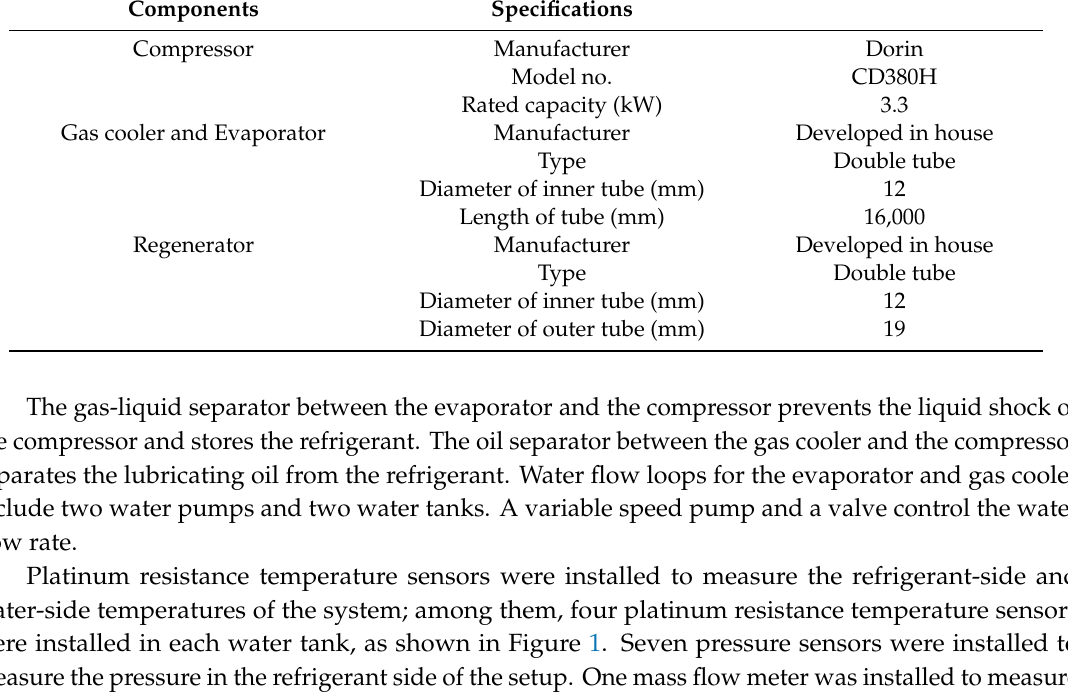
Figure 1. Schematic of the experimental setup. Table 1. Specifications of the main components of the system.